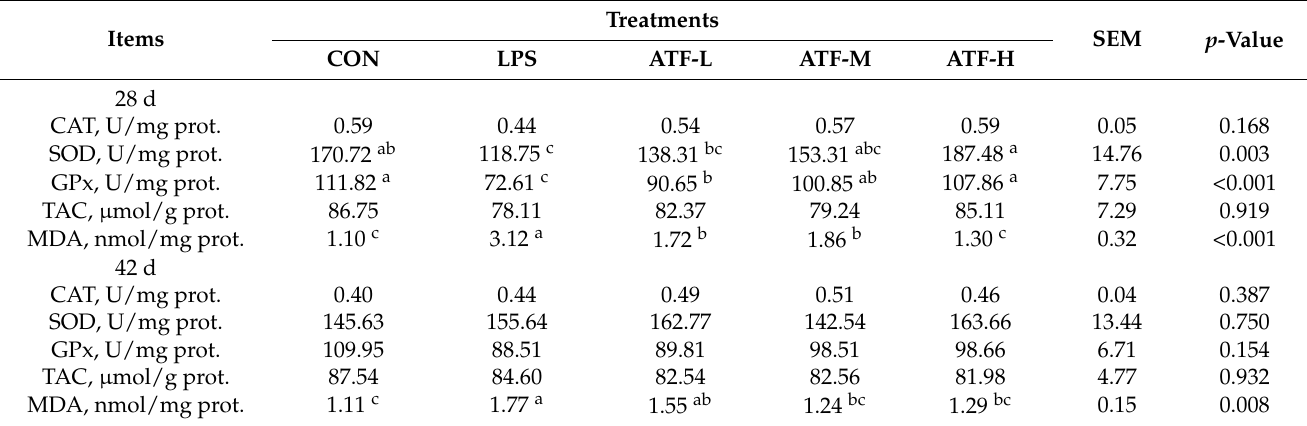
Table 7. Effect of ATF on splenic antioxidant indexes in broilers challenged with LPS.